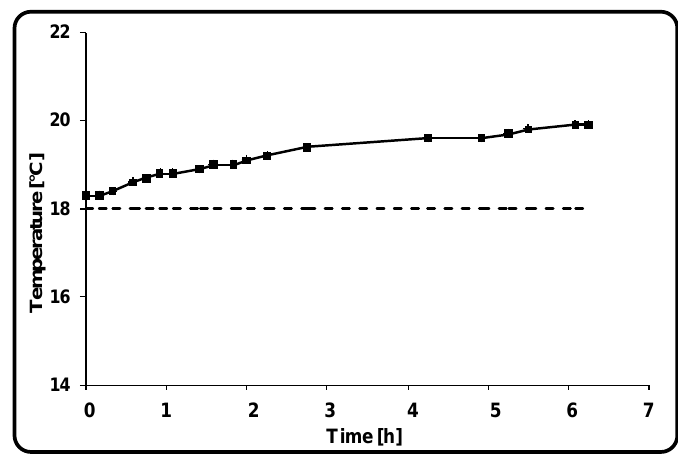
Figure 6. Marble powder paste temperature as function of time.